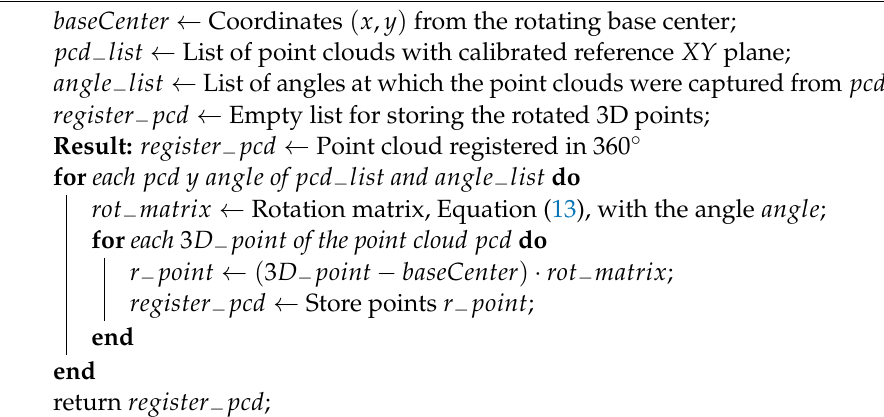
Figure 12. Result of the estimation of vegetative indexes in the Limonaria plant.